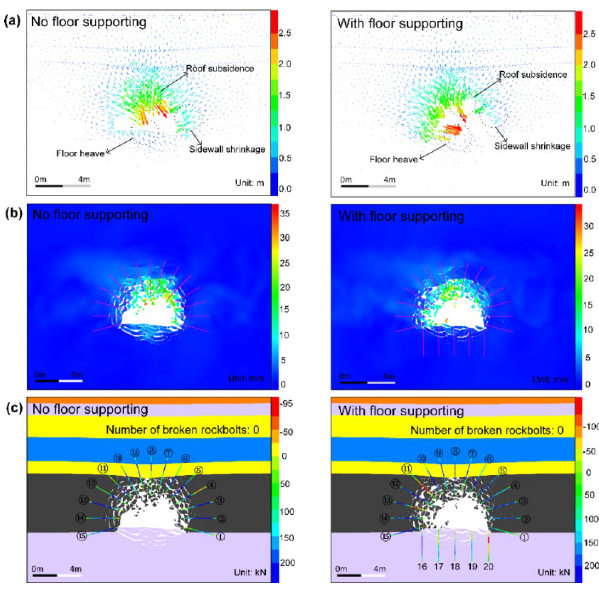
Fig. 23 a , b and c are simulated displacement vectors, velocity dis- tribution, and macroscopic failure patterns of the tunnel and rockbolt axial forces